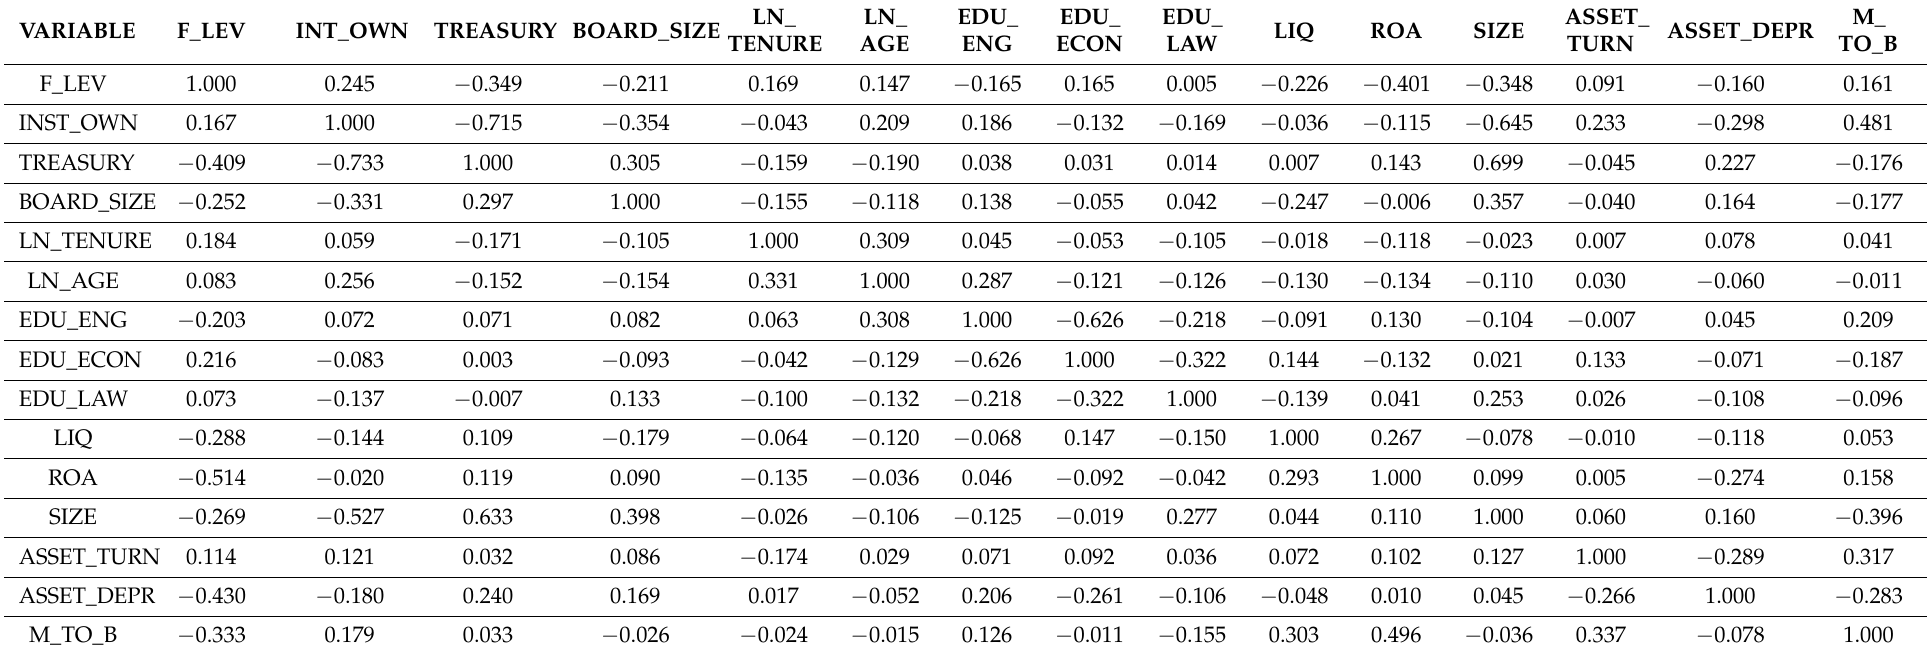
Table 3. Pairwise correlations—Pearson (upper triangle) and Spearman (lower